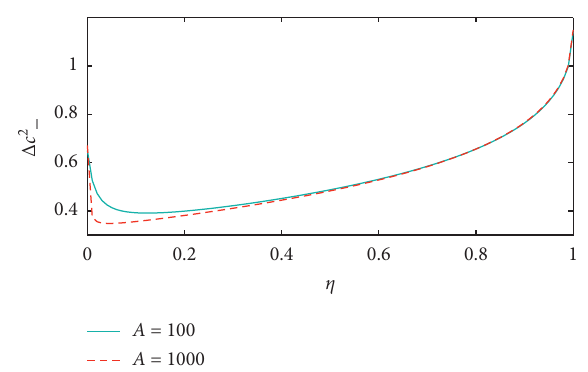
Figure 4: Plots of the minus quadrature variance (equation (25)) versus η for κ � 0 . 8, ε � 0 . 399, n th � 0 . 15 and for different values of the linear gain